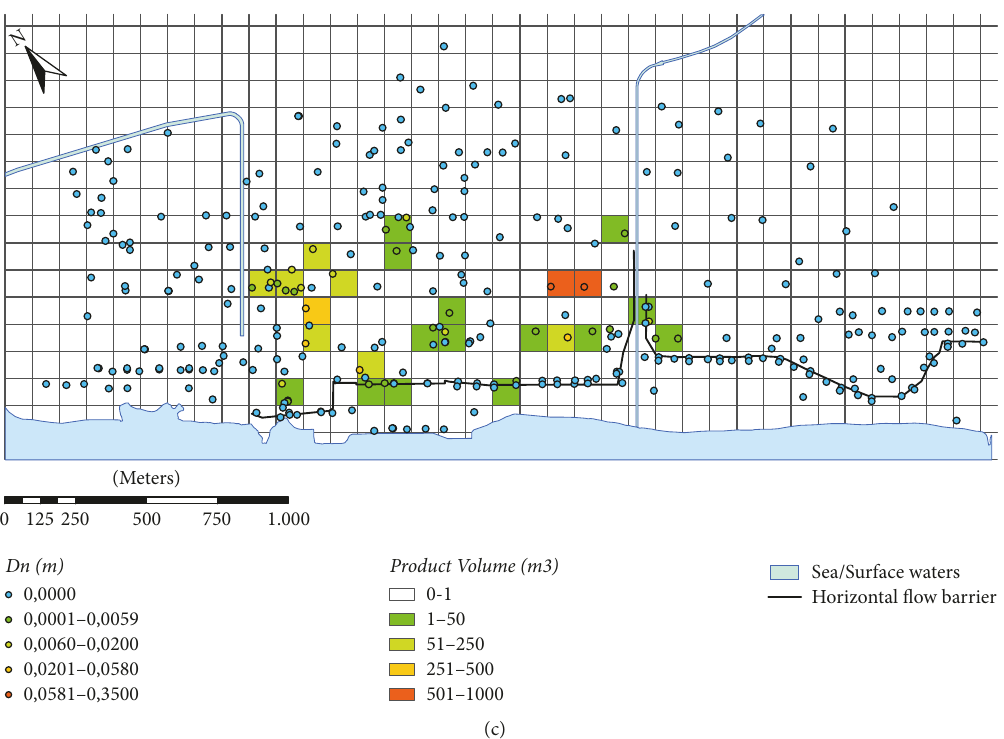
Figure 6: Product volume distribution in the study site at June 2013. The product volume was calculated using Vertical Equilibrium Model and Thiessen polygons (a), grid at regular square mesh (200 × 200), (b) and grid at regular square mesh (100 × 100) (c).